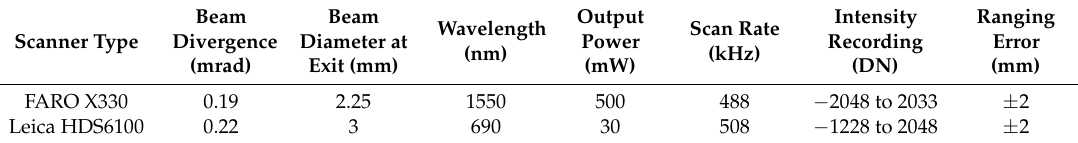
Table 2. Technical specifications for the terrestrial laser scanners. Ranging error is defined as the standard deviation of systematic measurement error at below 25